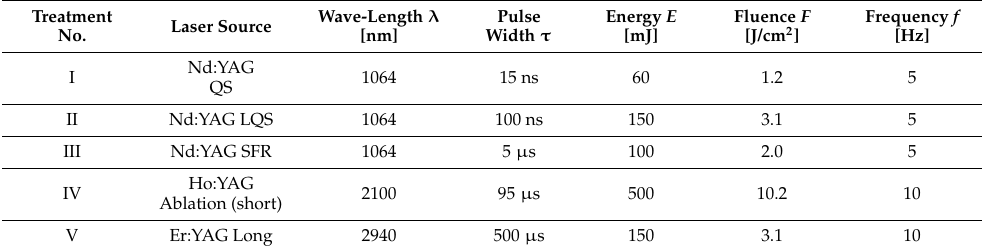
Table 2. Laser parameters used for treatments, all in modality